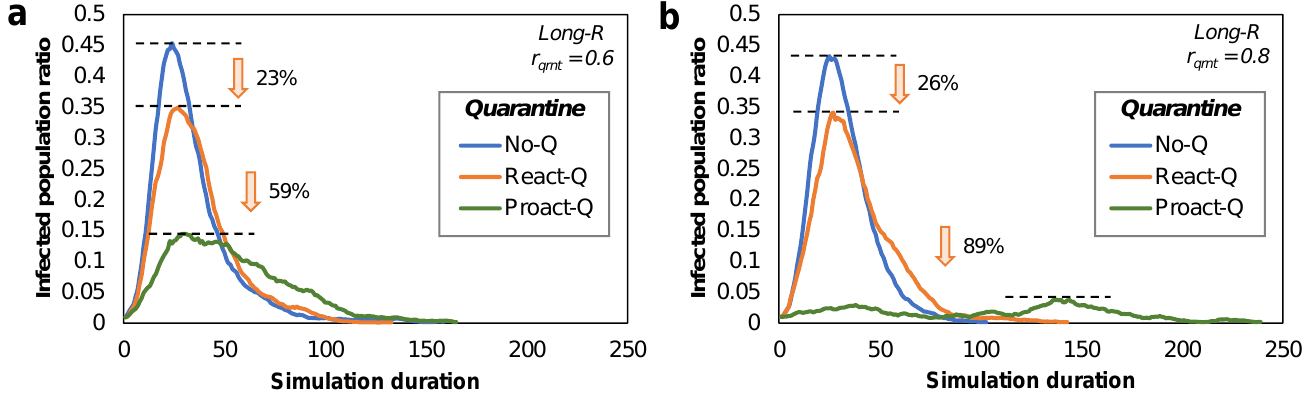
Figure 6. Overview of the evolution of epidemic outbreaks with long patient recurrence (long-R) from the perspective of the three quarantine policies. ( a ) The quarantine ratio is set to r qrnt = 0.6, before which the phase transition in the infected population ratio occurs. ( b ) The quarantine ratio is set to r qrnt = 0.8, after which the phase transition in the infected population ratio occurs. The decreases in the infected population ratios are shown as relative percentage for each quarantine